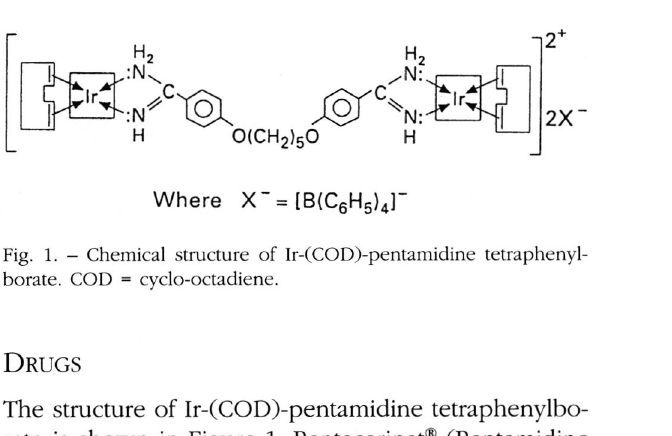
DRUGS The structure of Ir-(COD)-pentamidine tetraphenylbo­ rate is shown in Figure 1. Pentacarinat®